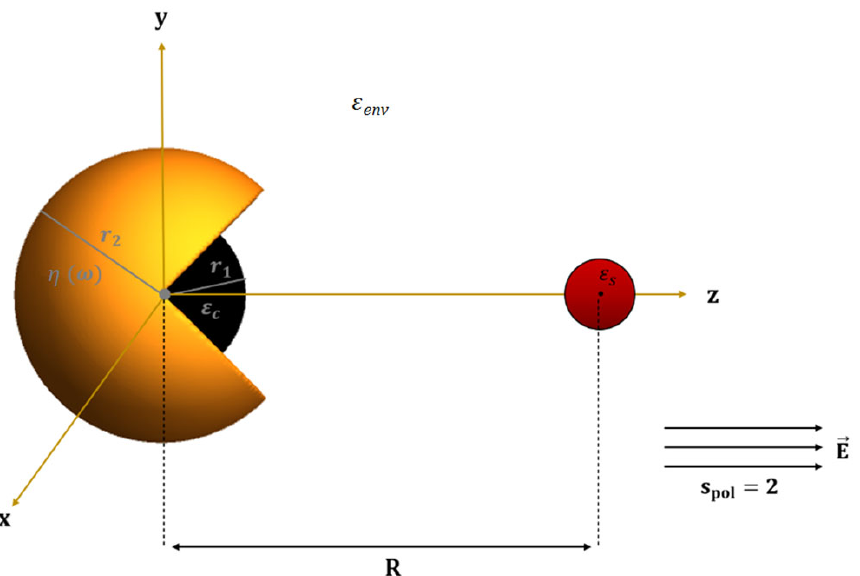
Figure 1. Schematic configuration of the hybrid system: An SQD with dielectric constant ε s is coupled to an MNS with outer radius r 2 and inner radius r 1 . The MNS is made of gold with dielectric function η ( ω ) . With ε c and ε env we represent the dielectric constants of the core and the environment,